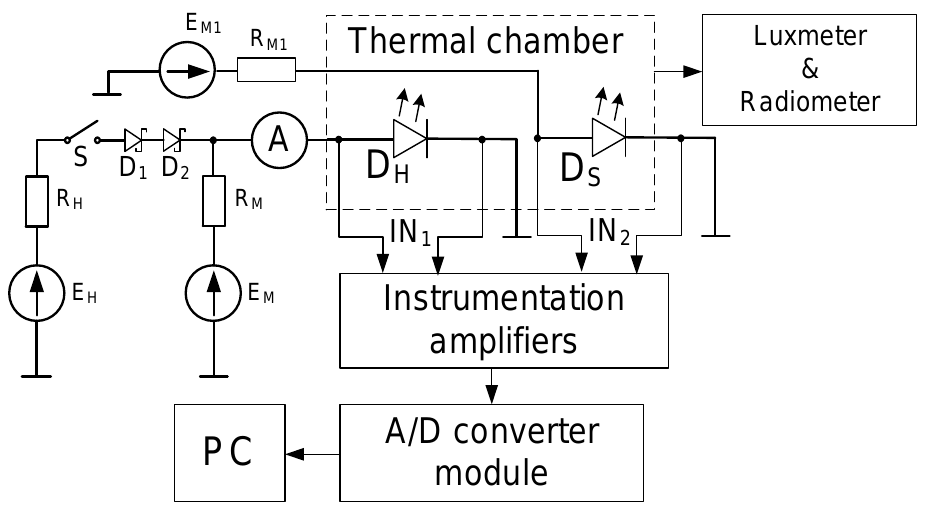
Figure 2. Diagram of the custom measurement set-up. Abbreviations: PC—personal computer, A/D—analog-digital